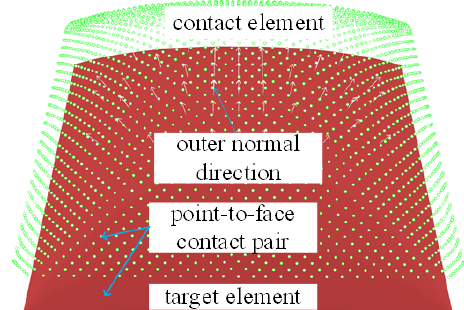
Figure 4. Point-to-surface contact pair model.